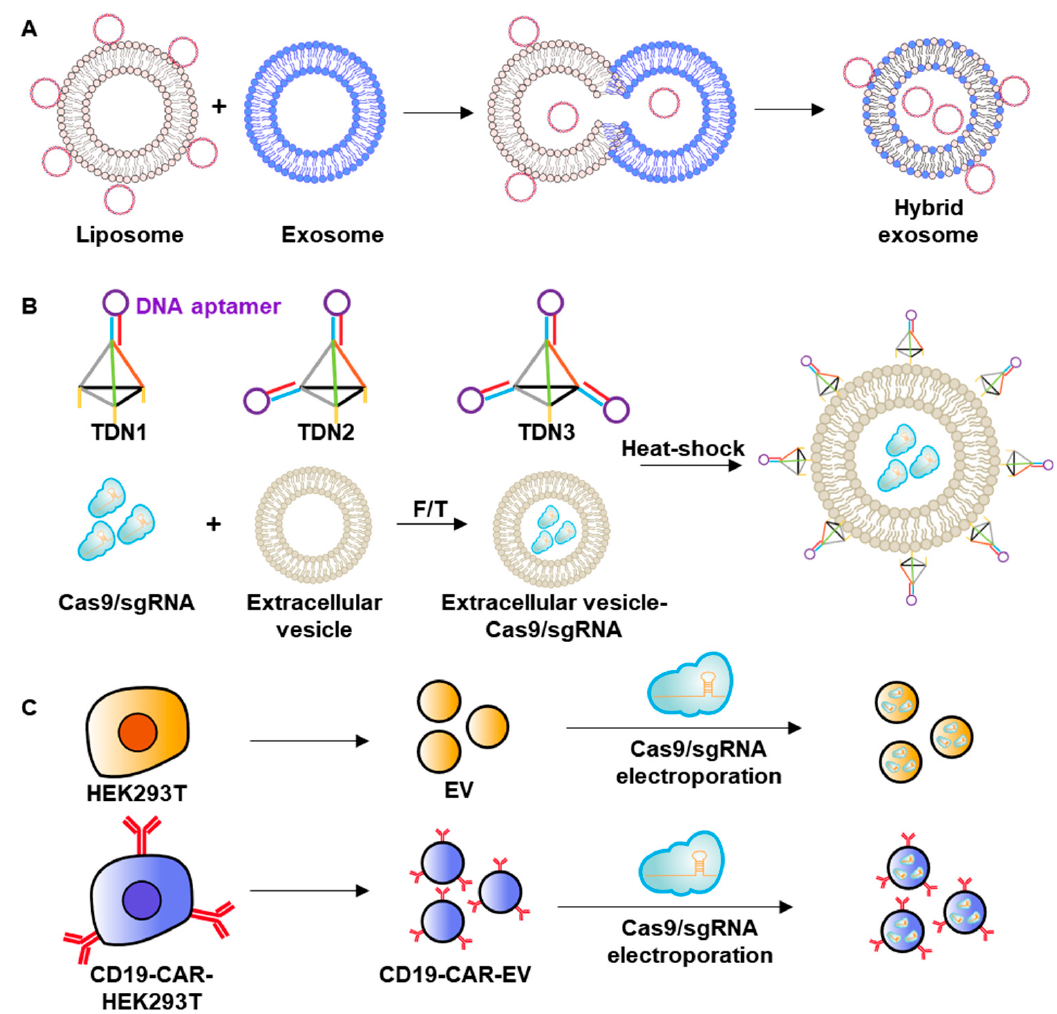
Figure 4. Extracellular vesicles for delivery of genome-editing components. ( A ) Exosome-liposome hybrid nanoparticles for delivery of plasmid DNA encoding Cas9 and sgRNA. Adapted from [86], WILEY-VCH, 2018. ( B ) DNA aptamer-conjugated extracellular vesicles for Cas9/sgRNA delivery. Adapted from [41], Oxford University Press, 2020. ( C ) Chimeric antigen receptor-extracellular vesicles for Cas9 ribonucleoprotein with complexed sgRNA. Adapted from [43], Elsevier,